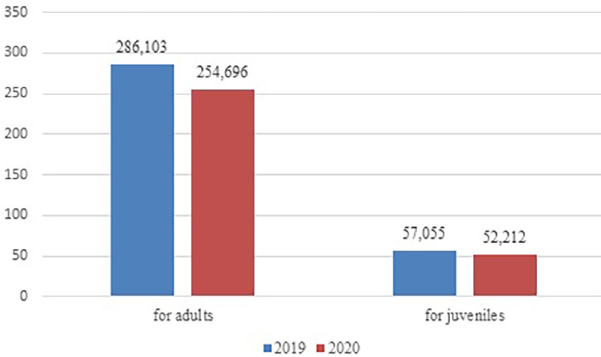
Figure 2. Comparation of completed cases in the probation system between 2019 and 2020. Source: Own analyzes based on the statistics of the Ministry of Justice, Department of Strategy and European Funds, MS-S40r Report on the activity of the probation court service for the year 2019, 2020.